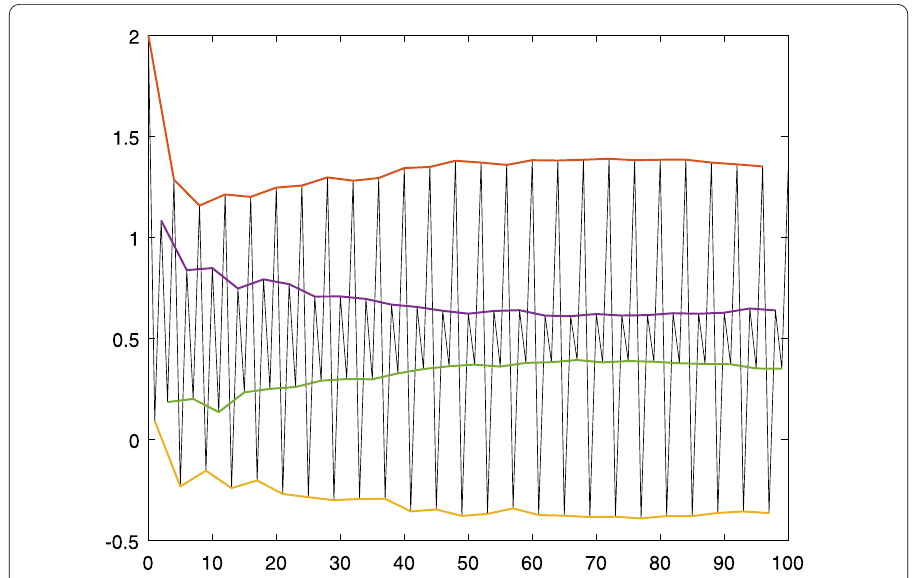
Figure 1 K = 2, a (0) = –1, a (1) = 1, ˆ g = 1. One sample trajectory, showing the dynamics of the solution (black line) and the four limits for e = 0 (red), e = 1 (yellow), e = 2 (blue) and e = 3 (green).